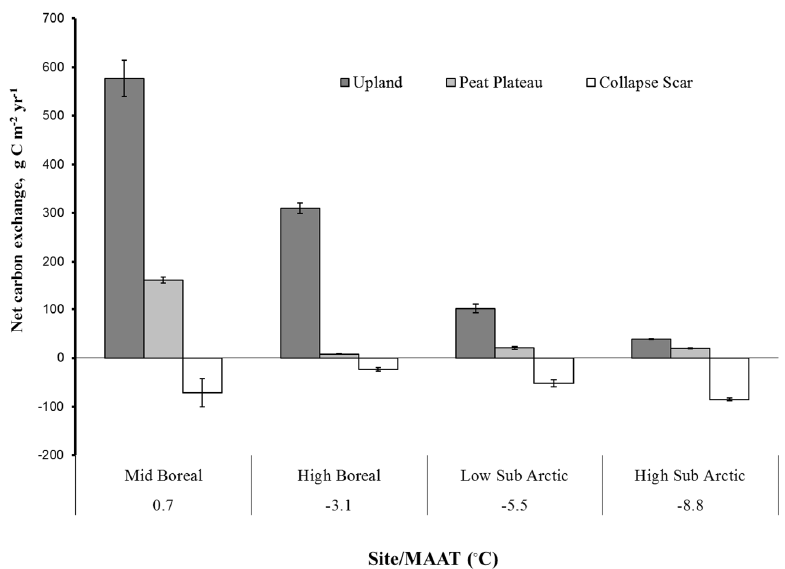
Figure 8. Seasonal net carbon exchange (NCE) for different sites and landform positions. MATT (°C) is mean annual air temperature.